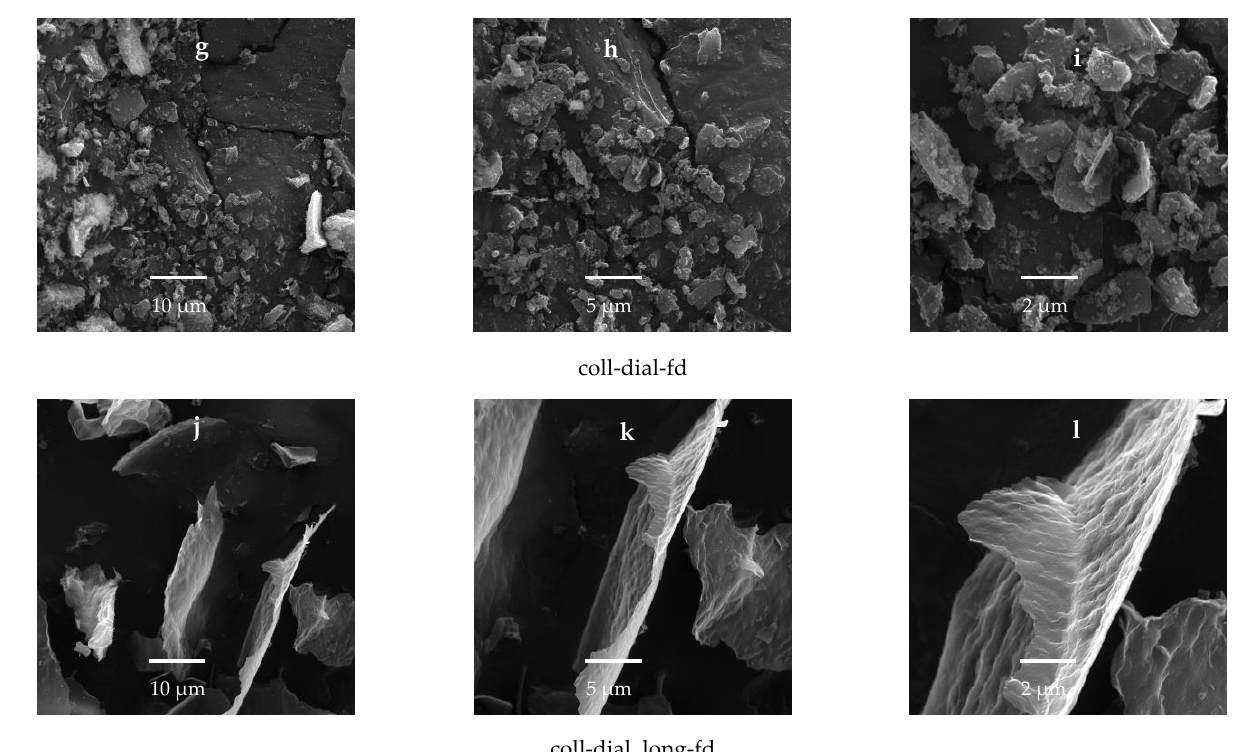
Figure 3. SEM images for representative zeolites: reference MCM-56 ( a – c ), coll-fd ( d – f ), coll-dial-fd ( g – i ), and coll-dial_long-fd ( j – l ).